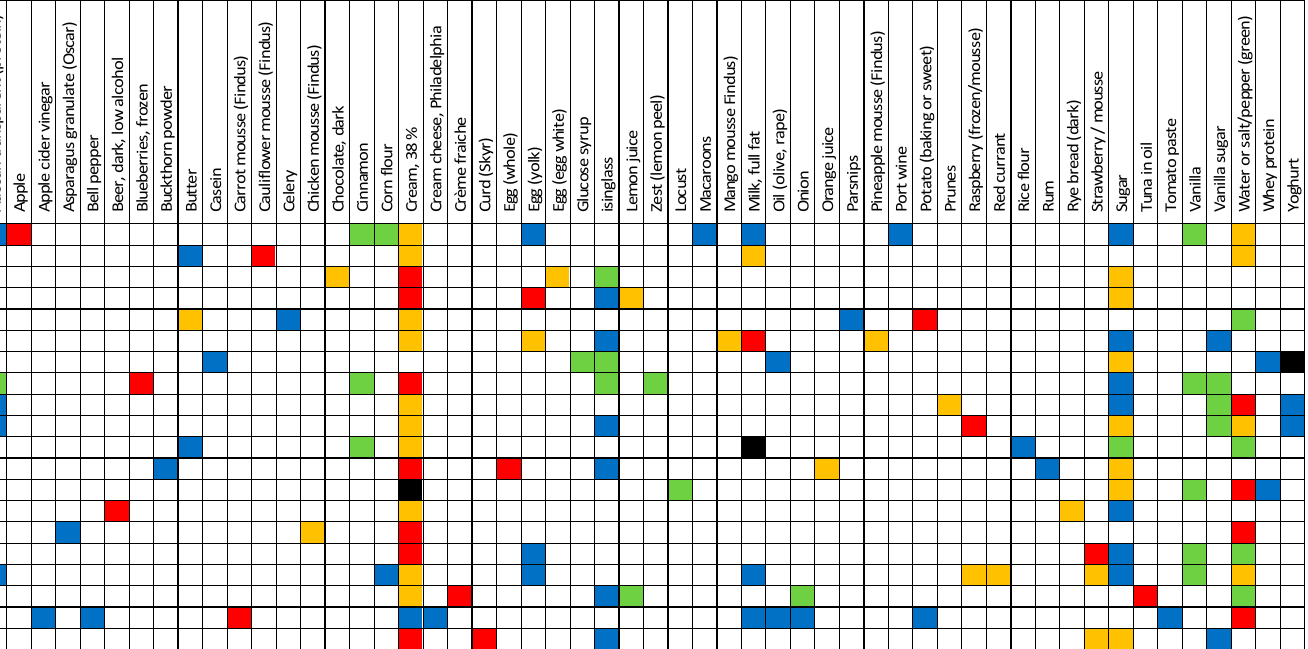
Figure 1. Ingredients in the 20 recipes of texture modified snacks where a specific amount of each ingredient is approximated due to proprietary rights. The relative content of all ingredients are given by the color codes. The estimated price of each snack is given in euros based on ingredients, but excluding the capacity cost.